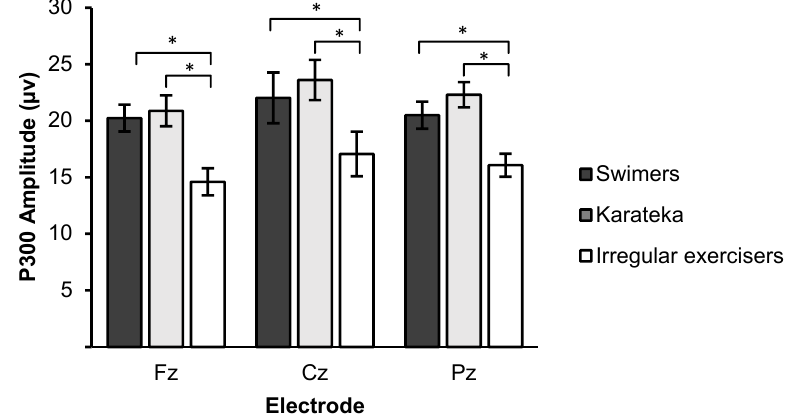
Figure 1. Mean P3 amplitude from the swimmers, karateka, and irregular exercisers during auditory oddball task. * significant difference at p > 0.05.